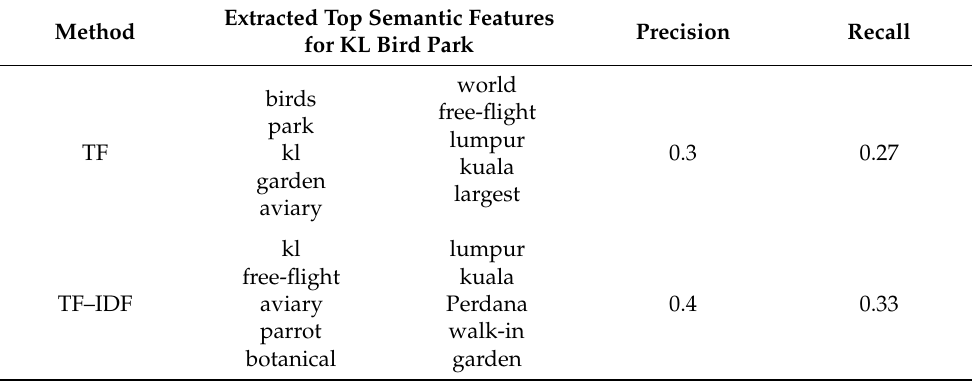
Table 9. Extracted top semantic terms of the baseline and proposed methods.